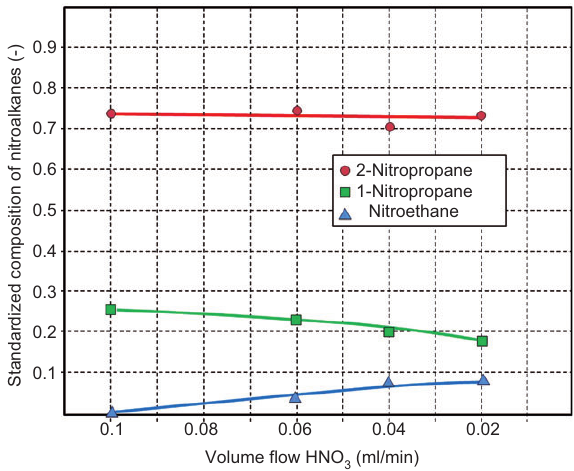
Figure 8 Standardized concentration ratio of nitroalkanes depending on volume flow of liquid HNO . Molar ratio between nitric 3 acid and propane is set to one. Volume flow corresponds with residence time (increase of residence time from left to right).